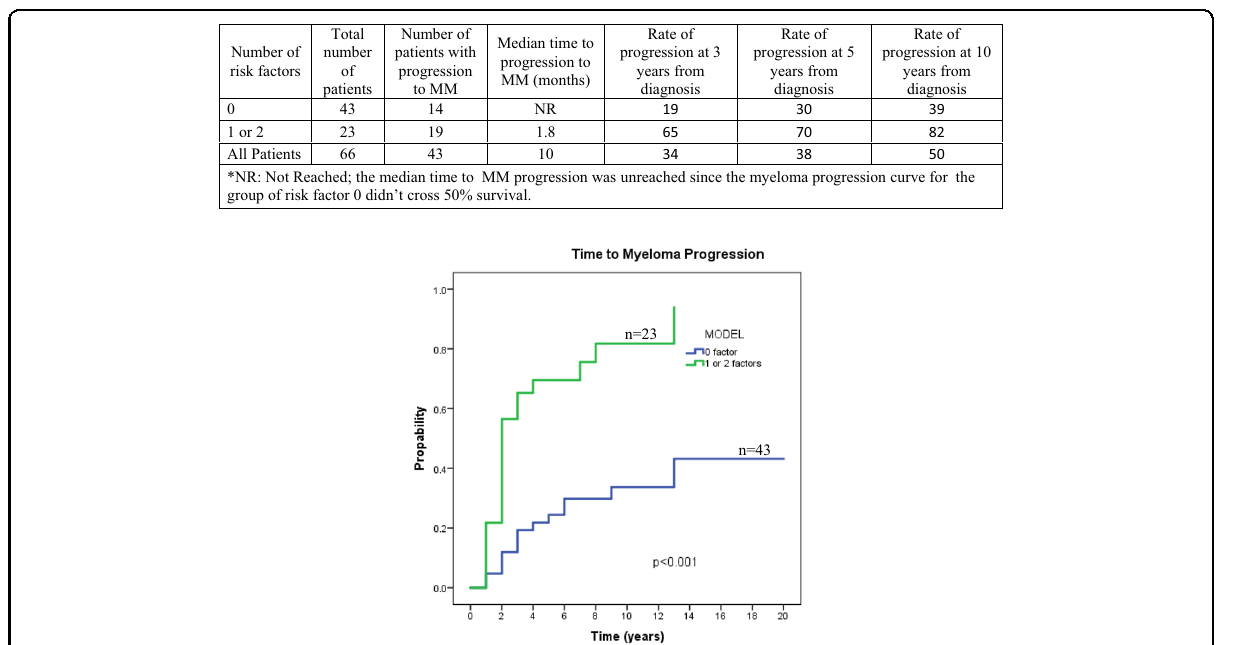
Fig. 1 Model of high and low-risk SP by two risk factors (plasmacytoma size >10 cm. At diagnosis and persistent serum paraprotein 1 year after treatment) divided in to 2 groups: 0 risk factors and 1 and/or 2 risk factors. The rate of progression to MM was signi fi cantly higher in patients who had either a plasmacytoma size of ≥ 10 cm at diagnosis and/or persistent presence of serum paraprotein 1 year after